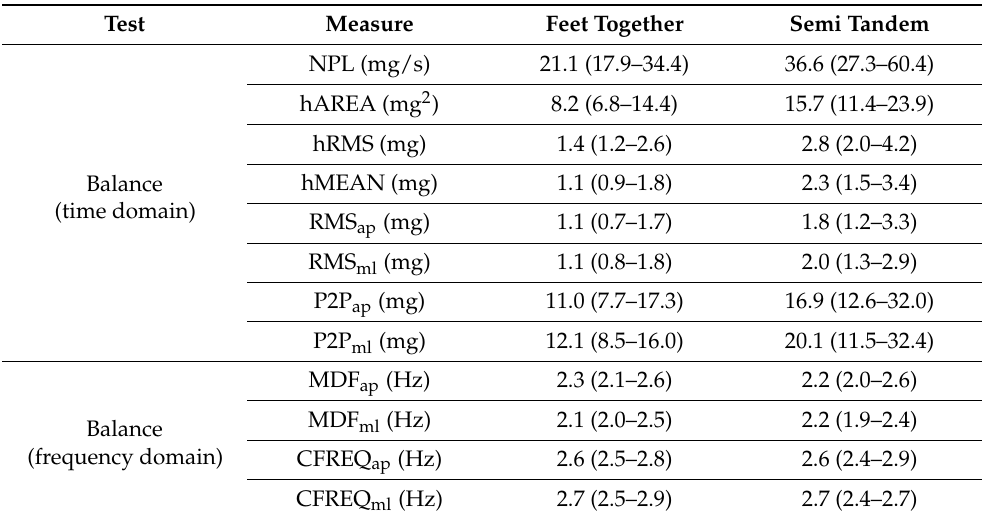
Table 4. Descriptive data for balance sensor tests. Variables are described in terms of the median (Q1–3) n =